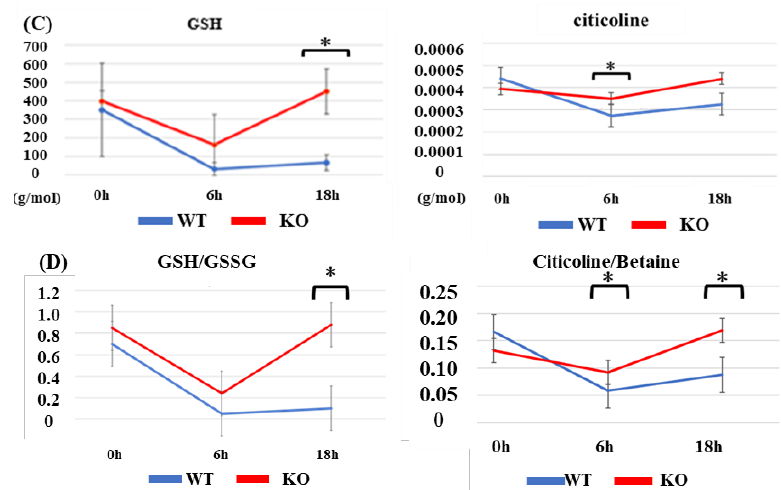
Figure 4. Metabolomics of brain tissue following CLP. ( A ) Volcano plot for differential brain tissue metabolite expression 18 h following induction of sepsis in CypD KO vs. WT mice. Scattered points represent individual metabolites: the x -axis is the Log 2 (fold change) for the ratio KO-CLP-18 h vs. WT-CLP-18 h, whereas the y -axis is the Log ( p -value), where p -value is the probability that a metabolite has statistical significance in its differential expression. Red dots are, thus, metabolites significantly over-expressed in KO-CLP-18 h, and green dots are metabolites significantly underexpressed in KO-CLP-18 h vs. WT-CLP-18 h. ( B ) CDP-Choline/citicoline and betaine were intermediaries related to the Kennedy pathway of phosphatidylcholine synthesis. The KO group maintained a higher brain GSH value than the WT group at all timepoints (0, 6, and 18 h), which was statistically significant at 18 h. ( C ) Citicoline was also maintained at a high level in the KO group at 6 and 18 h after CLP. ( D ) Focusing on the redox effect and calculating the ratio of GSH to GSSG or the ratio of citicoline to betaine, both ratios were maintained at a higher level in the KO group. Data are expressed as means ± SD, * p < 0.05, n = 3.